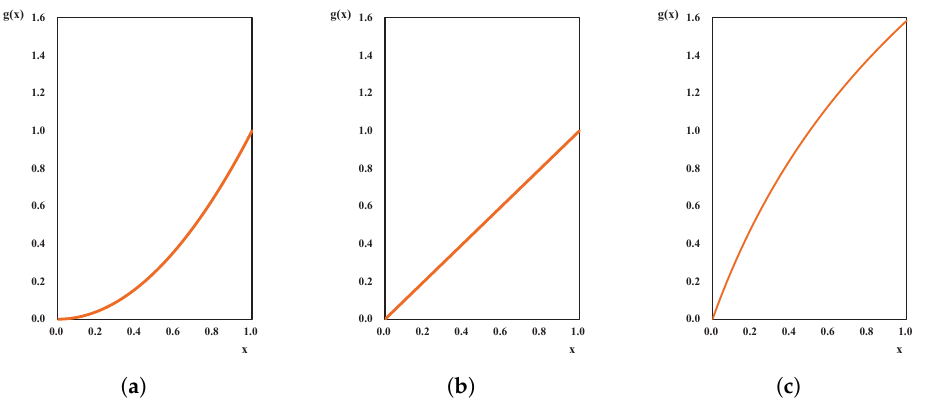
Figure 6. Values of different g ( · ) in the range [0, 1]. ( a ) g ( x ) = x 2 ; ( b ) g ( x ) = | x | ; ( c ) g ( x ) = ( 2 | x | + 1 ) . log 2